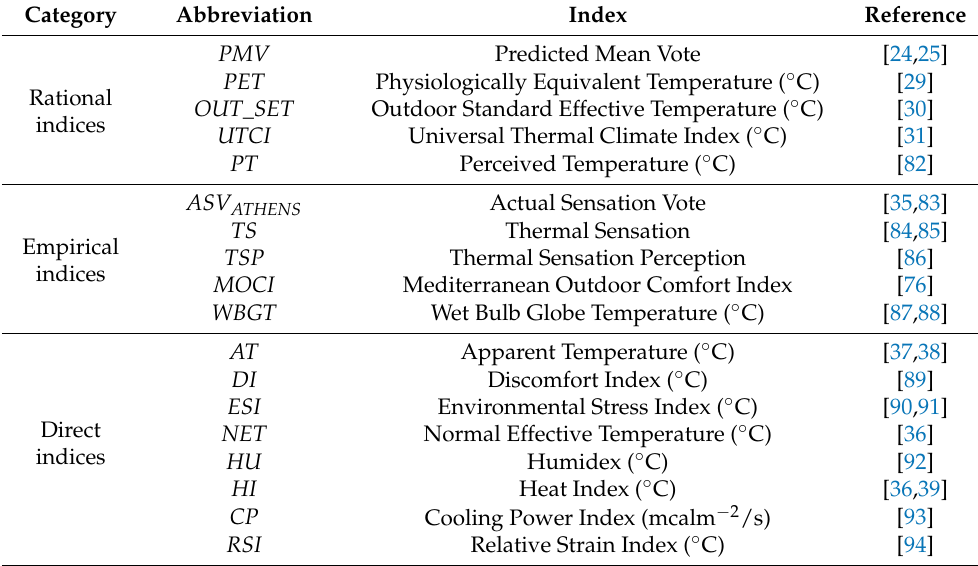
Table 4. Characteristics of the selected